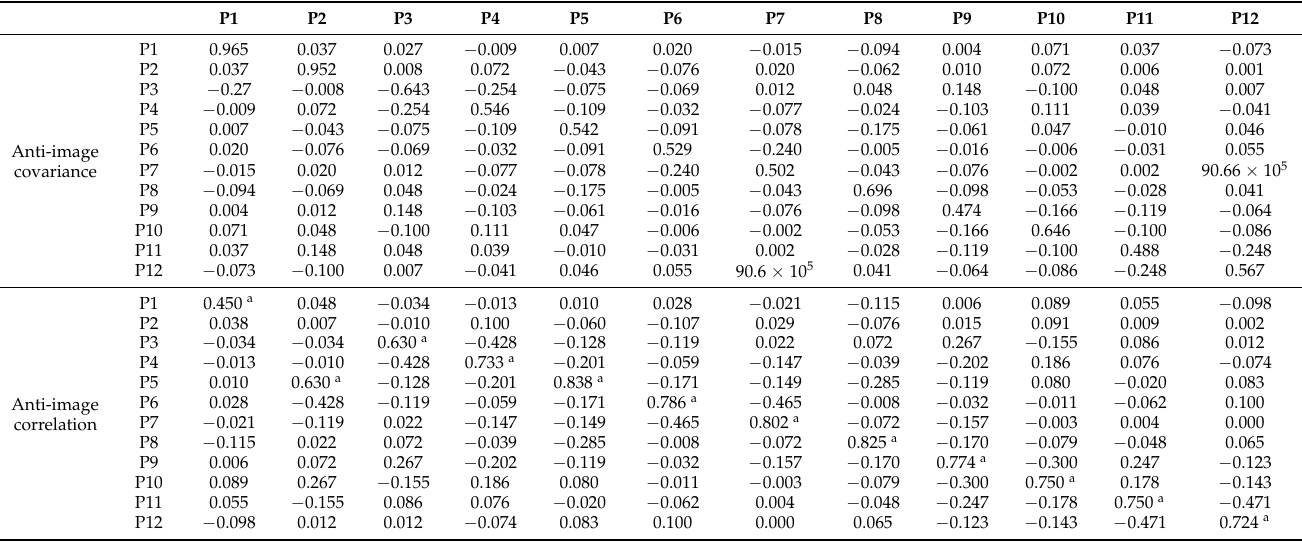
Table 10. Anti-image matrices, measures of sampling adequacy (MSA) with 12 items.